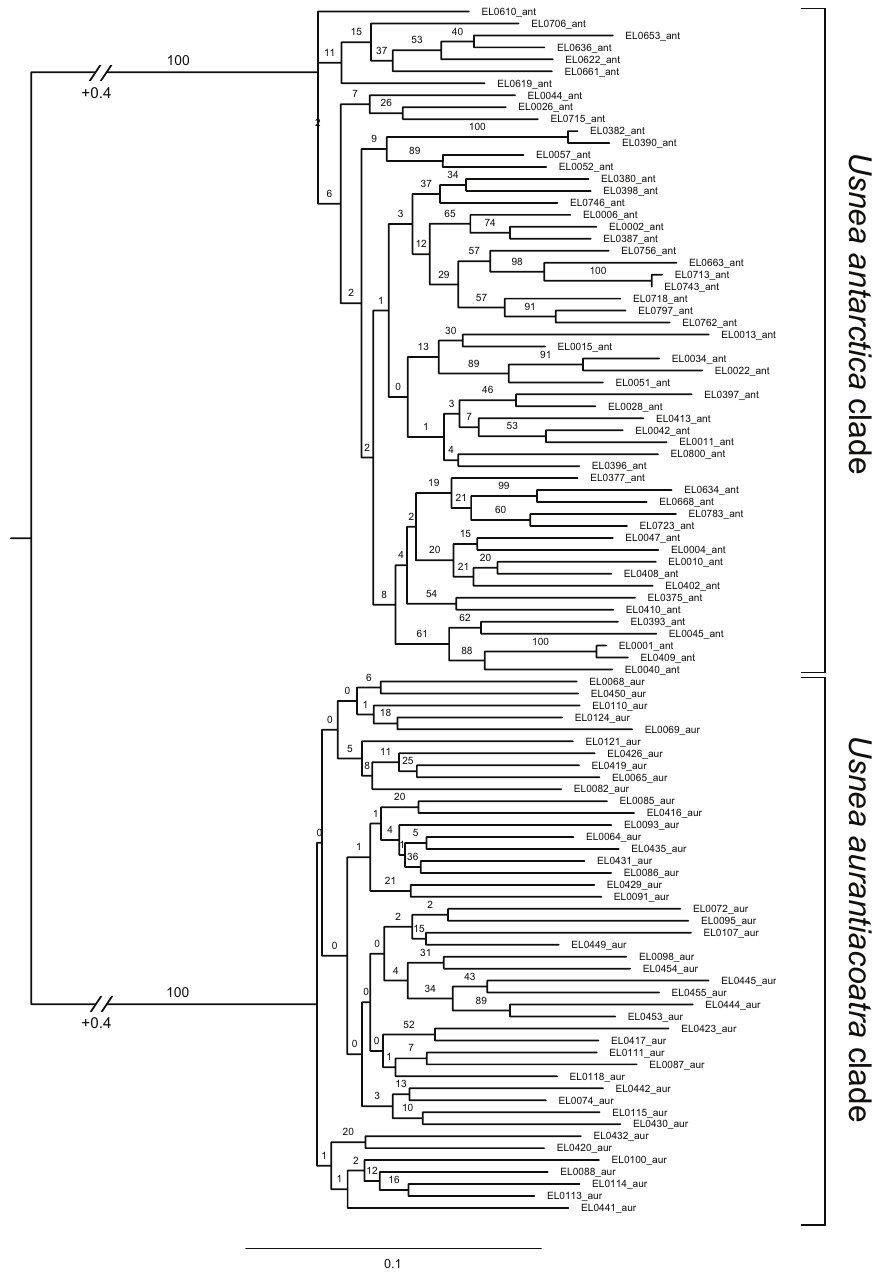
Figure 1. Phylogenetic tree inferred from the U. antarctica and U. aurantiacoatra RADseq data. The clades of each species are highlighted by brackets. Bootstrap values are indicated at the branches. The unit of branch length is substitutions per site. Note that branches leading to both major clades were abbrevi- ated by 0.4 substitutions per